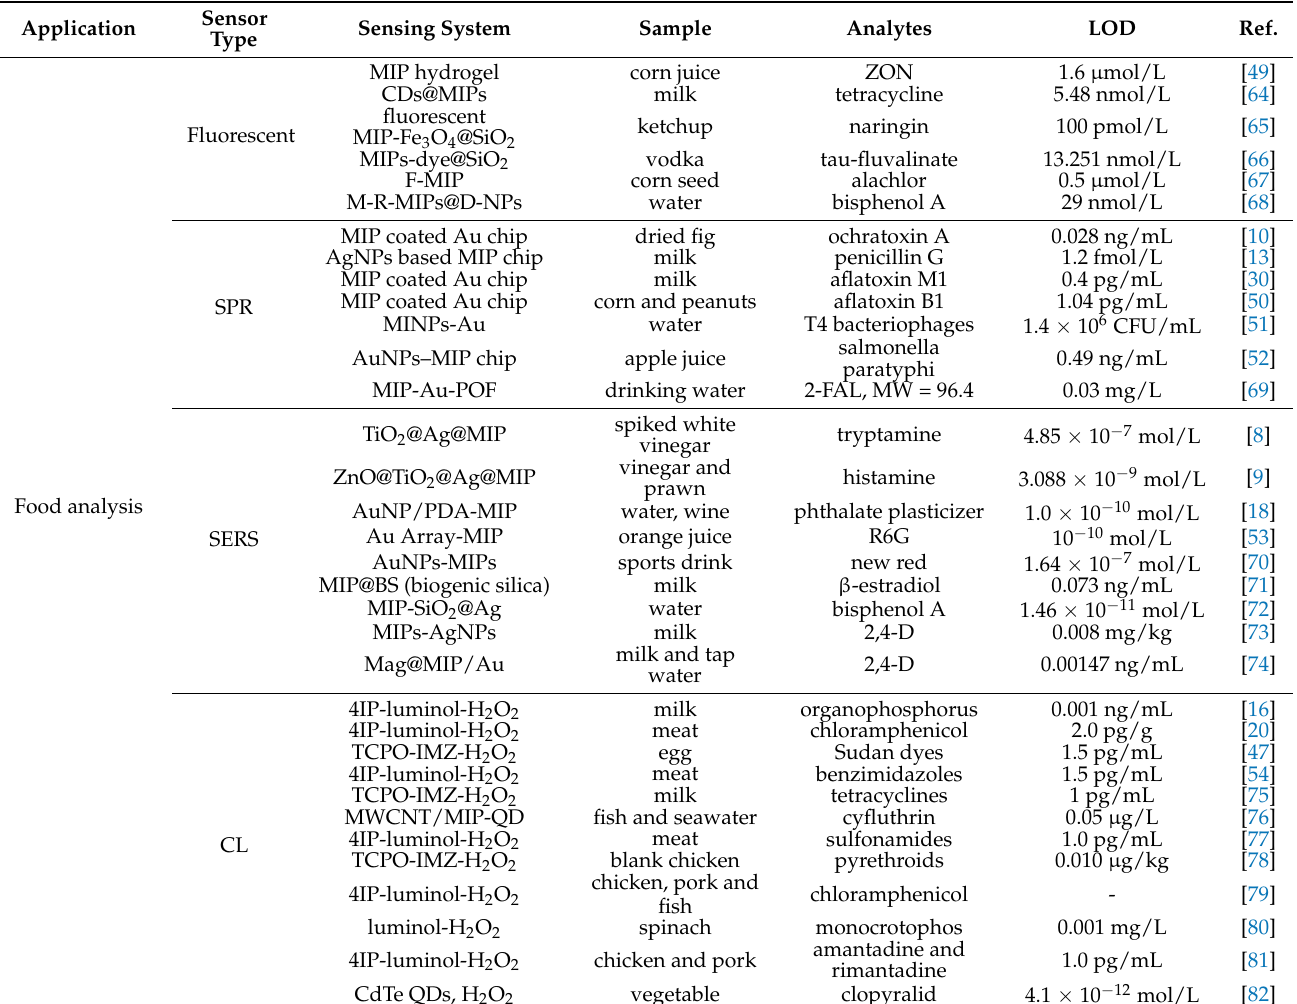
Table 1. Recent applications of MIP optical